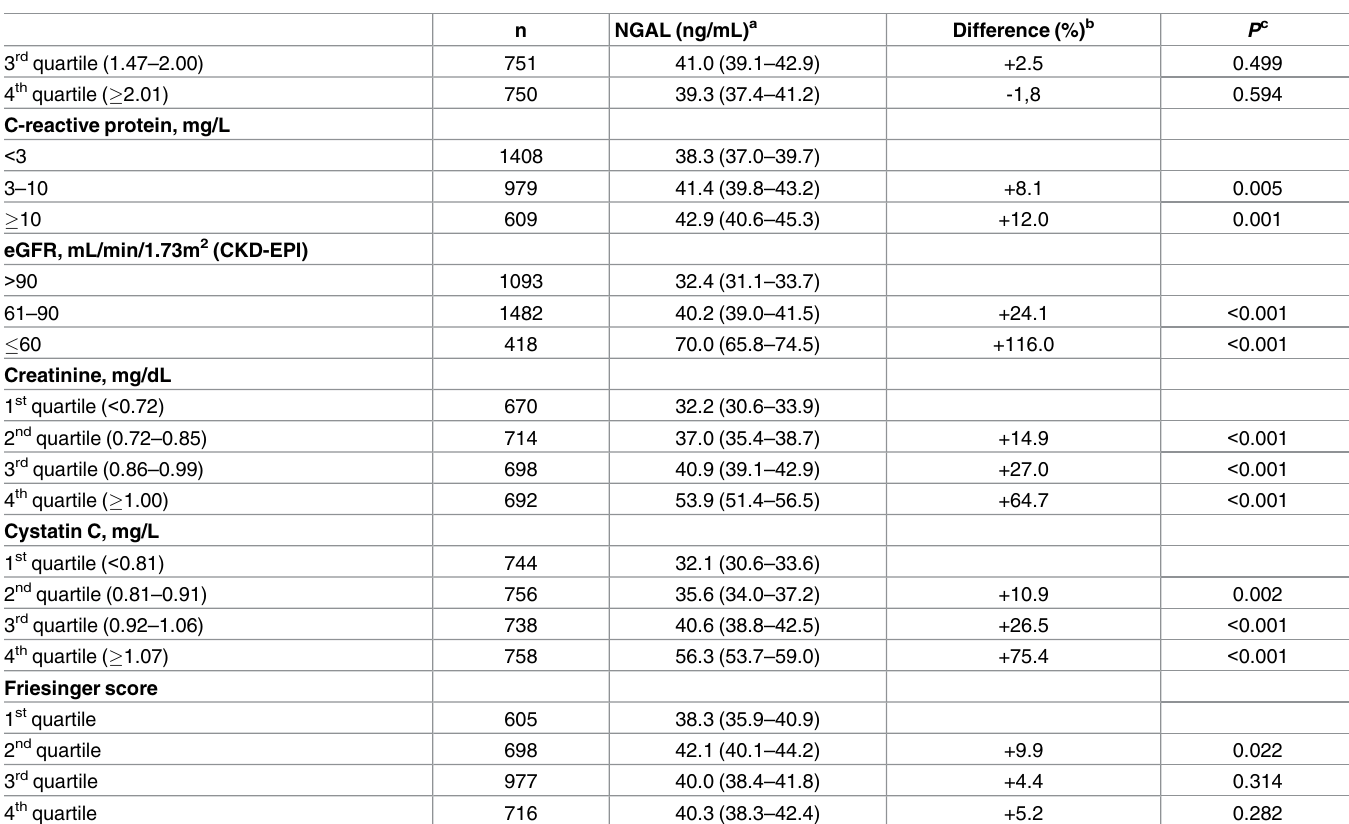
a Estimated marginal means and 95% confidence intervals obtained in a general linear model (ANOVA), adjusted for sex, gender, coronary artery disease, body mass index, diabetes mellitus, hypertension, smoking, LDL cholesterol, HDL cholesterol, triglycerides b Compared to the first category of each variable c Post hoc pairwise comparisons with the first category of each variable d Thresholds of 27 and 26 kg apply to males and females, respectively e Thresholds of 102 and 88 cm apply to males and females,